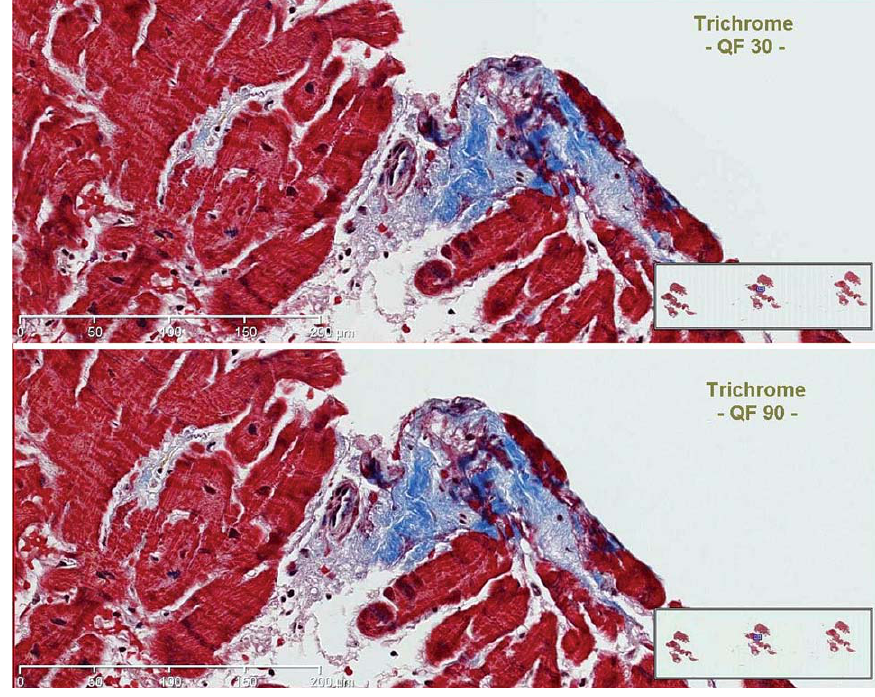
Fig. 4. (Trichrome screen shots at QF 30 and QF 90 display no loss of visual